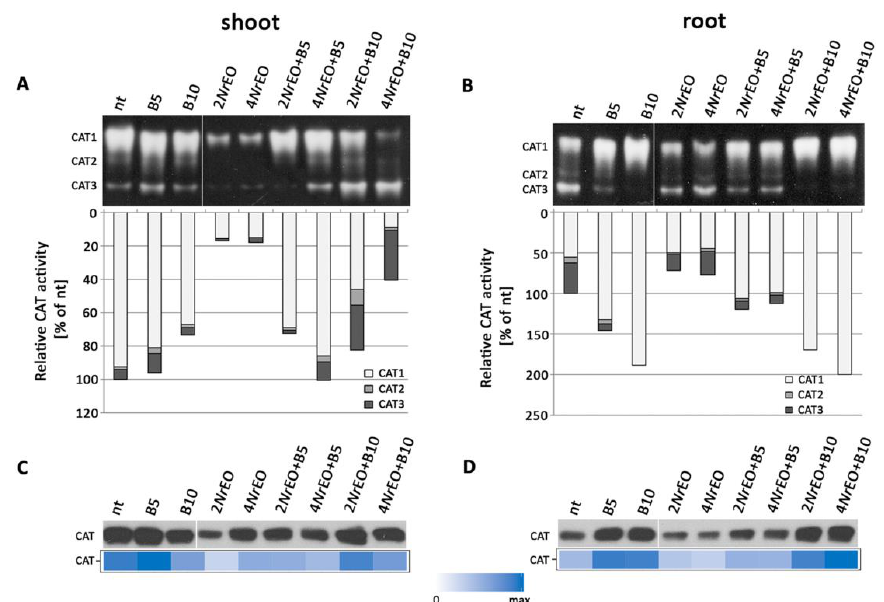
Figure 4. Catalases (CAT) activity in Arabidopsis grown in vitro , measured 10 days after treatment with BASTA applied at two concentrations B5 (5 mg l −1 ) and B10 (10 mg l −1 ), N. rtanjensis essential oil applied at two concentrations 2% (2 Nr EO) and 4% (4 Nr EO), and of their combinations. ( A , B ) CAT activity stain after native-PAGE separation (5 µ g per lane of total protein), in shoots and roots, respectively. The detected activities were measured densitometrically and presented as relative CAT activity (% of control) in comparison to non-treated plants (nt). ( C , D ) CAT immunoblot (20 µ g of soluble proteins per line) in shoots and roots, respectively. Heat-maps show relative abundances of CAT proteins. Maximal values on the color scales represent maximal values recorded for each immunoblot.